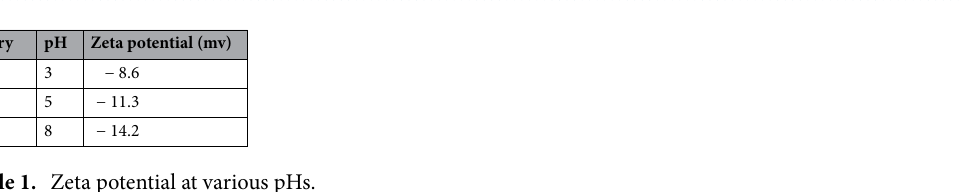
Figure 8. Gaussian distribution of charge for the Fe 3 O 4 @BNPs@ZnS-CdS at different pHs ( a ) pH = 3, ( b ) pH = 5, ( c ) pH = 8 and ( d ) Zeta potential versus pH curve for Fe 3 O 4 @BNPs@ZnS-CdS.